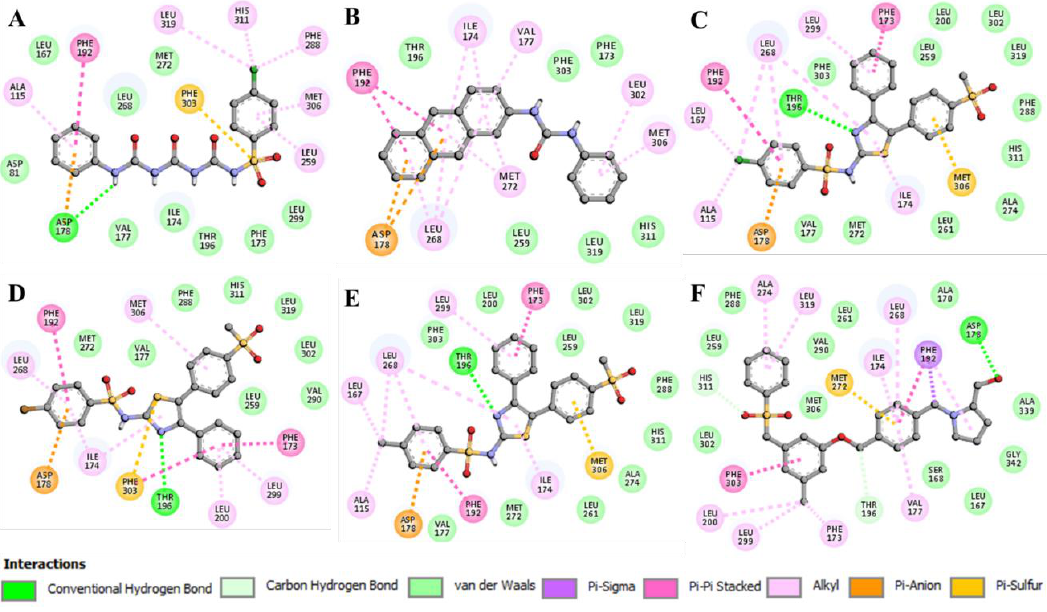
Figure 8. Interactions of selected compounds with SphK1. 2D structural representation of SphK1 residues interacting with ( A ) Compound 1 , ( B ) Compound 5 , ( C ) Compound 6 , ( D ) Compound 7 , ( E ) Compound 8 , and ( F ) PF-543.